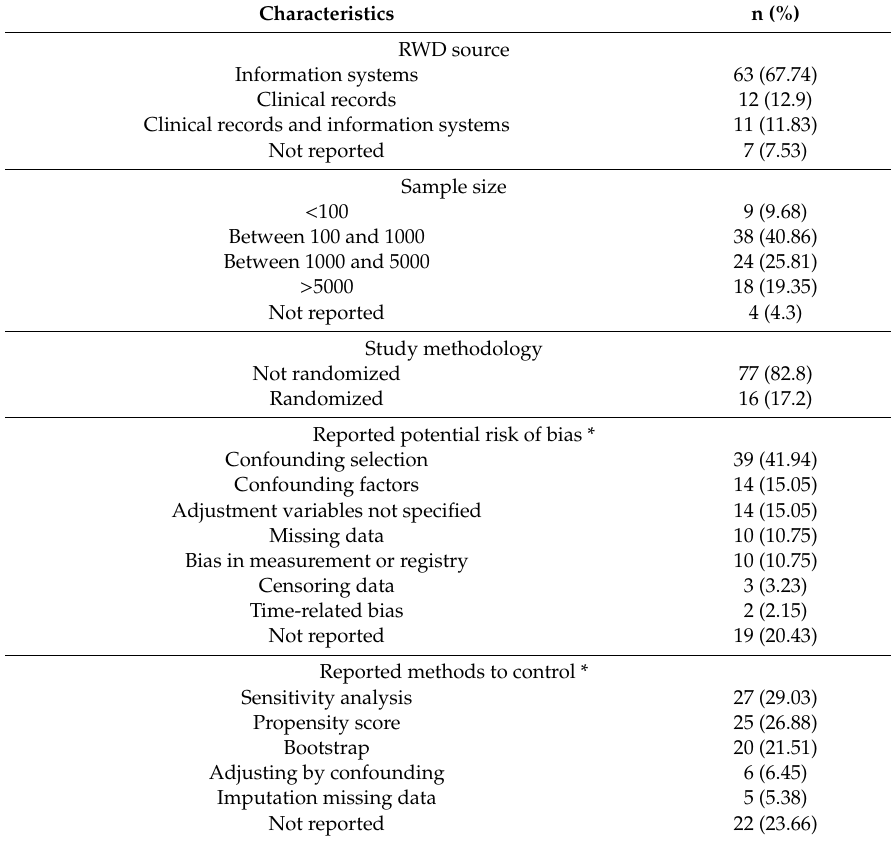
Table 2. Methodological information about Real World Data